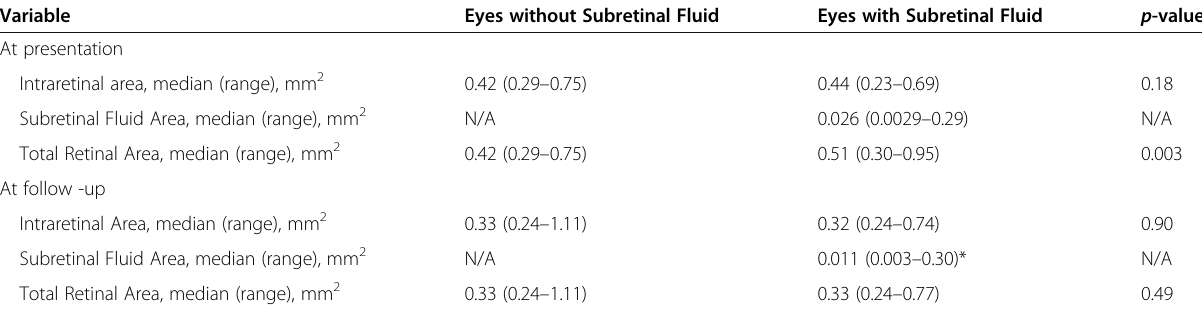
Table 3 Cross-sectional area of OCT structures in Eyes with Uveitic Cystoid Macular Edema, Comparing Eyes with and without Subretinal Fluid. N = 93